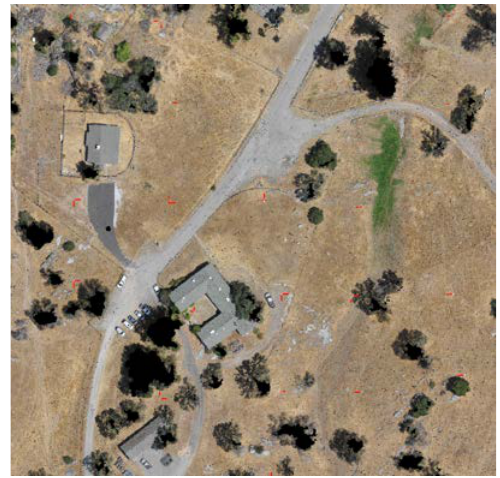
Figure 2: UAV-derived dense point cloud (full image scale sampling)